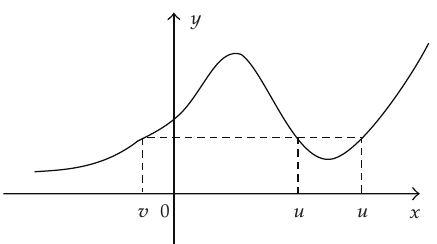
Figure 6: The picture of y (cid:2) f (cid:3) x (cid:4) /g (cid:3) x (cid:4) in (cid:3) 3 (cid:4) (cid:6) .